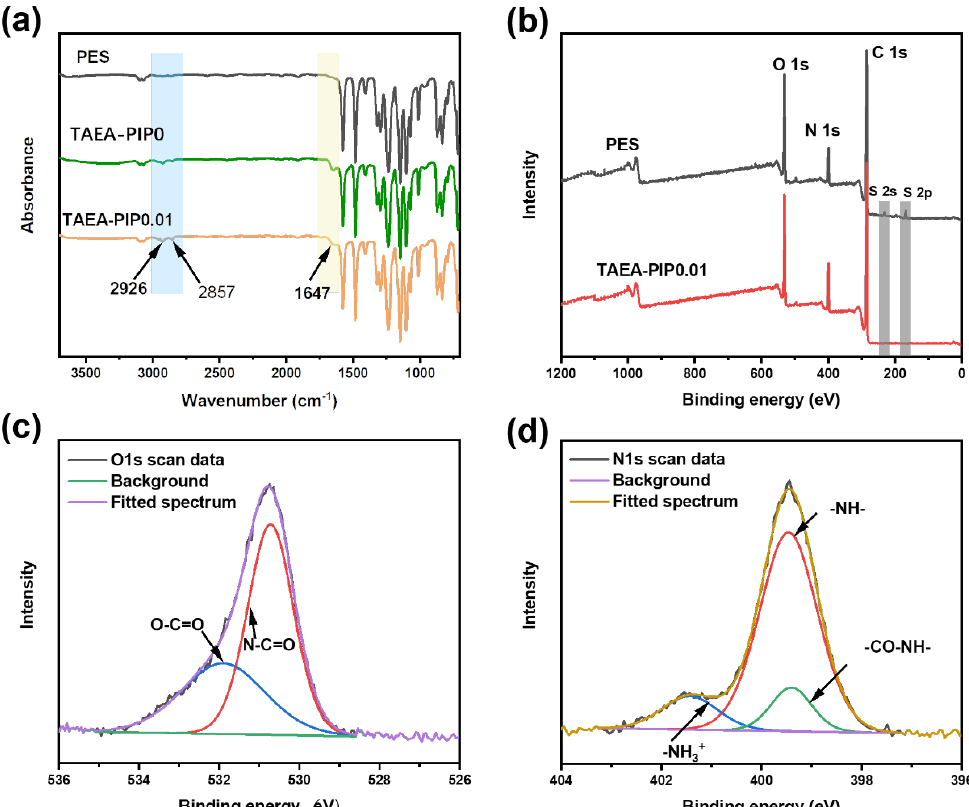
Figure 2. ( a ) FTIR spectra of the polyethersulfone (PES), tris(3-aminopropyl)amine (TAEA)-PIP0, and TAEA-PIP0.01 membranes; ( b ) XPS survey spectra of the PES and TAEA-PIP0.01 membranes; High-resolution XPS spectra of ( c ) O1s and ( d ) N1s for the TAEA-PIP0.01 membrane.